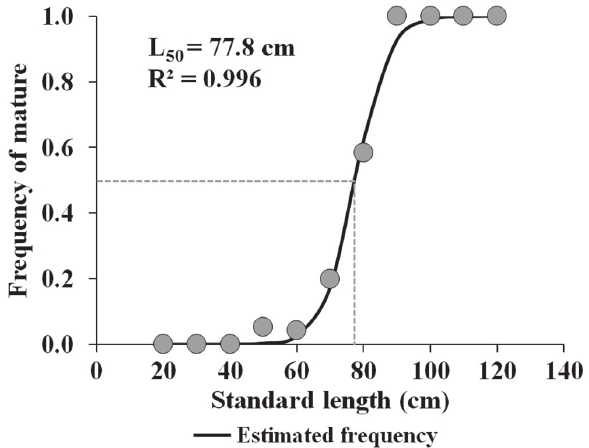
Fig. 3. Size at first sexual maturity in the red-tailed catfish Phractocephalus hemioliopterus specimens collected from the Xingu River in Pará, Brazil.